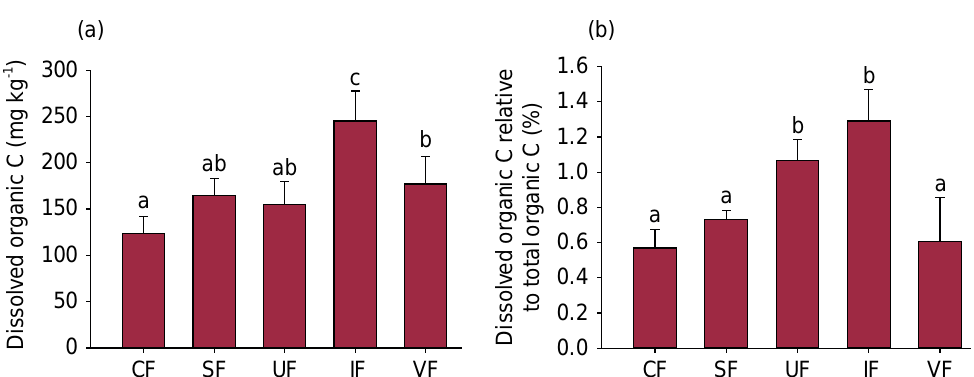
Figure 4. Dissolved organic C (DOC) of the A horizon in different forest areas (a); DOC proportion relative to total organic C (b). CF = Coruripe; UF = Umbaúba; VF = Nova Viçosa; SF = Sooretama; IF = Itaboraí, n = 3. Values followed by different letters are significantly different by the Duncan test